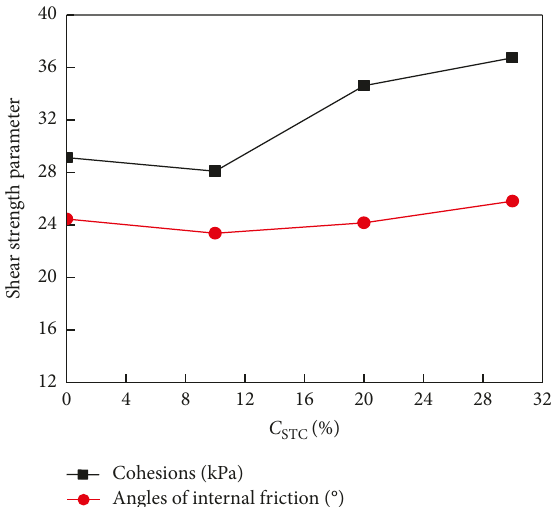
Figure 7: Variations of cohesion and internal friction angle for mixtures.